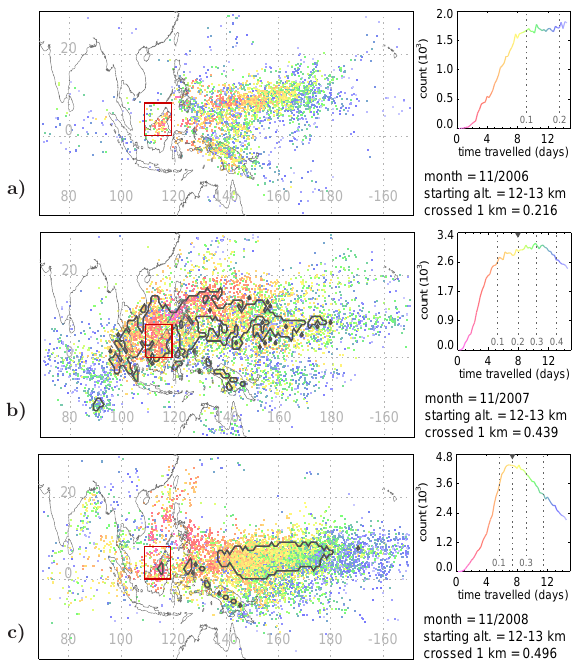
Fig. 5. As for Fig. 1 but focussing on trajectories started between 15–16km for the Novembers of 2006, 2007 and 2008.